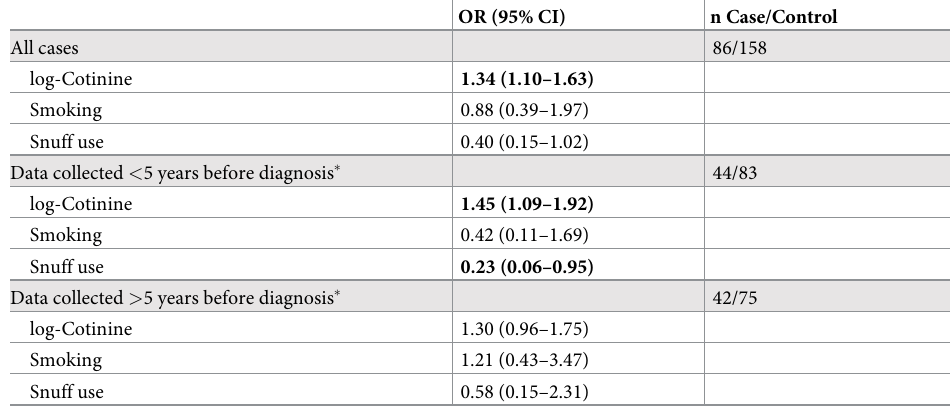
Table 4. Multivariable conditional logistic regression showing odds ratios (OR) and confidence interval (CI) for inflammatory bowel disease, subdivided by median time from data collection to